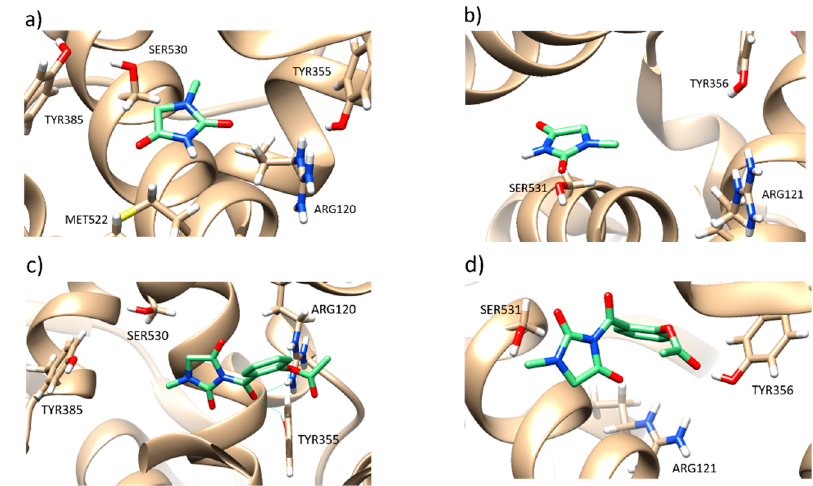
Figure 3. ( a ) and ( b ) Binding model of 1-MHD with cyclooxygenases-1 (COX-1) and cyclooxygenases-2 (COX-2). ( c ) and ( d ) Binding model of 2 with COX-1 and COX-2.